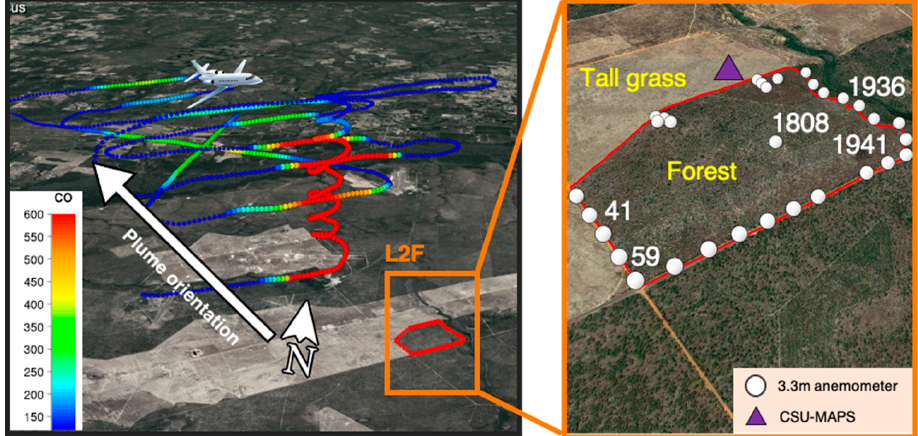
Figure 1. The panel on the left shows a 3-dimensional diagram of aircraft-measured CO enhancements (ppb) during the L2F prescribed burn. The L2F burn plot is outlined in red. The panel on the right is zoomed in on L2F burn plot and shows the location of the 3.3-m anemometers and the CSU-MAPS tall tower.